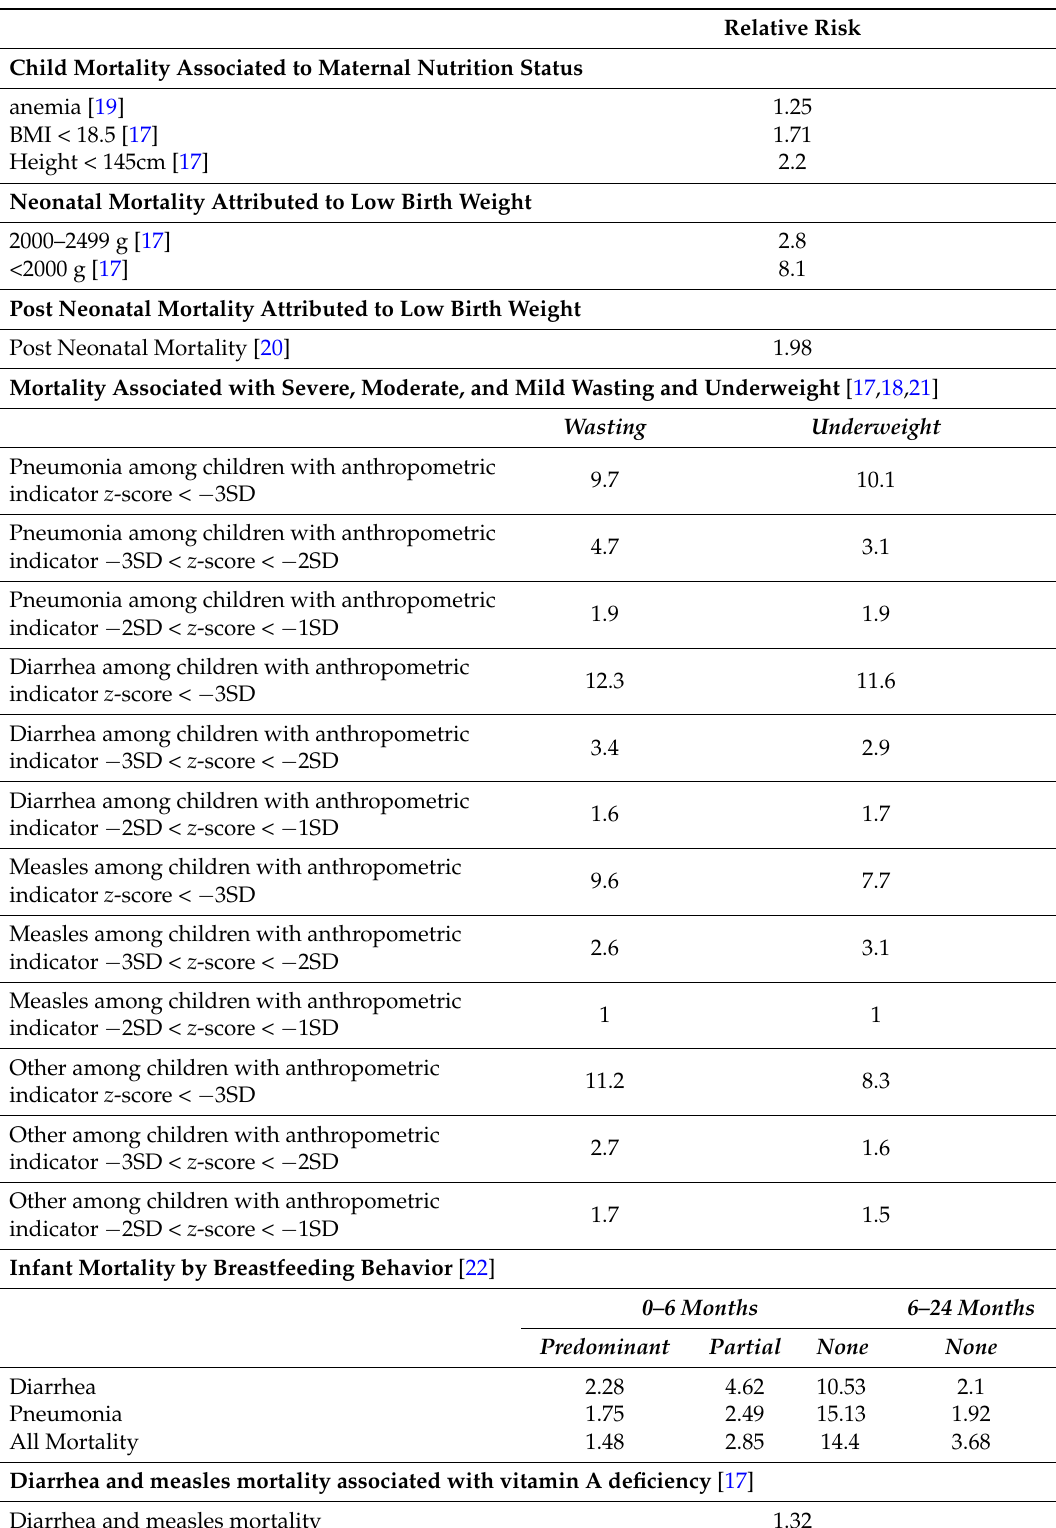
Table 2. Relative risk of